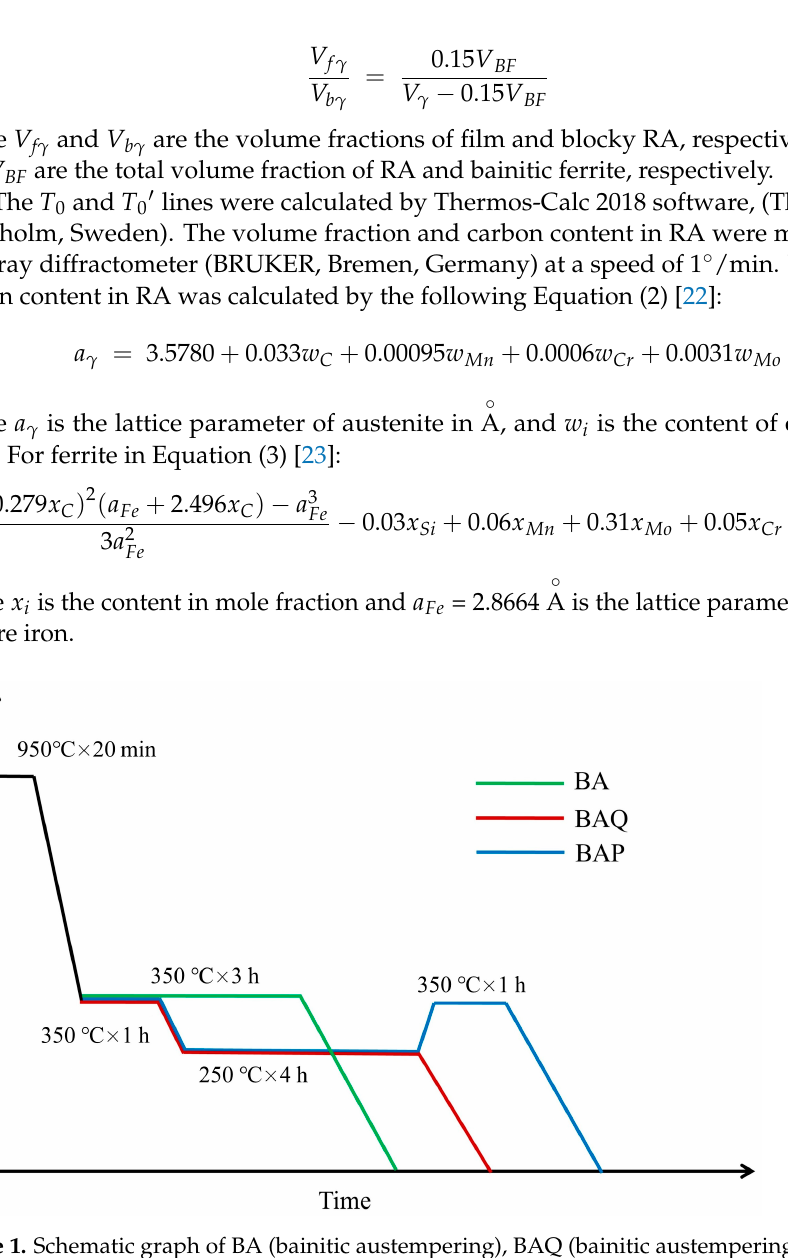
Figure 1. Schematic graph of BA (bainitic austempering), BAQ (bainitic austempering-quenching), and BAP (bainitic austempering-partitioning) treatments.